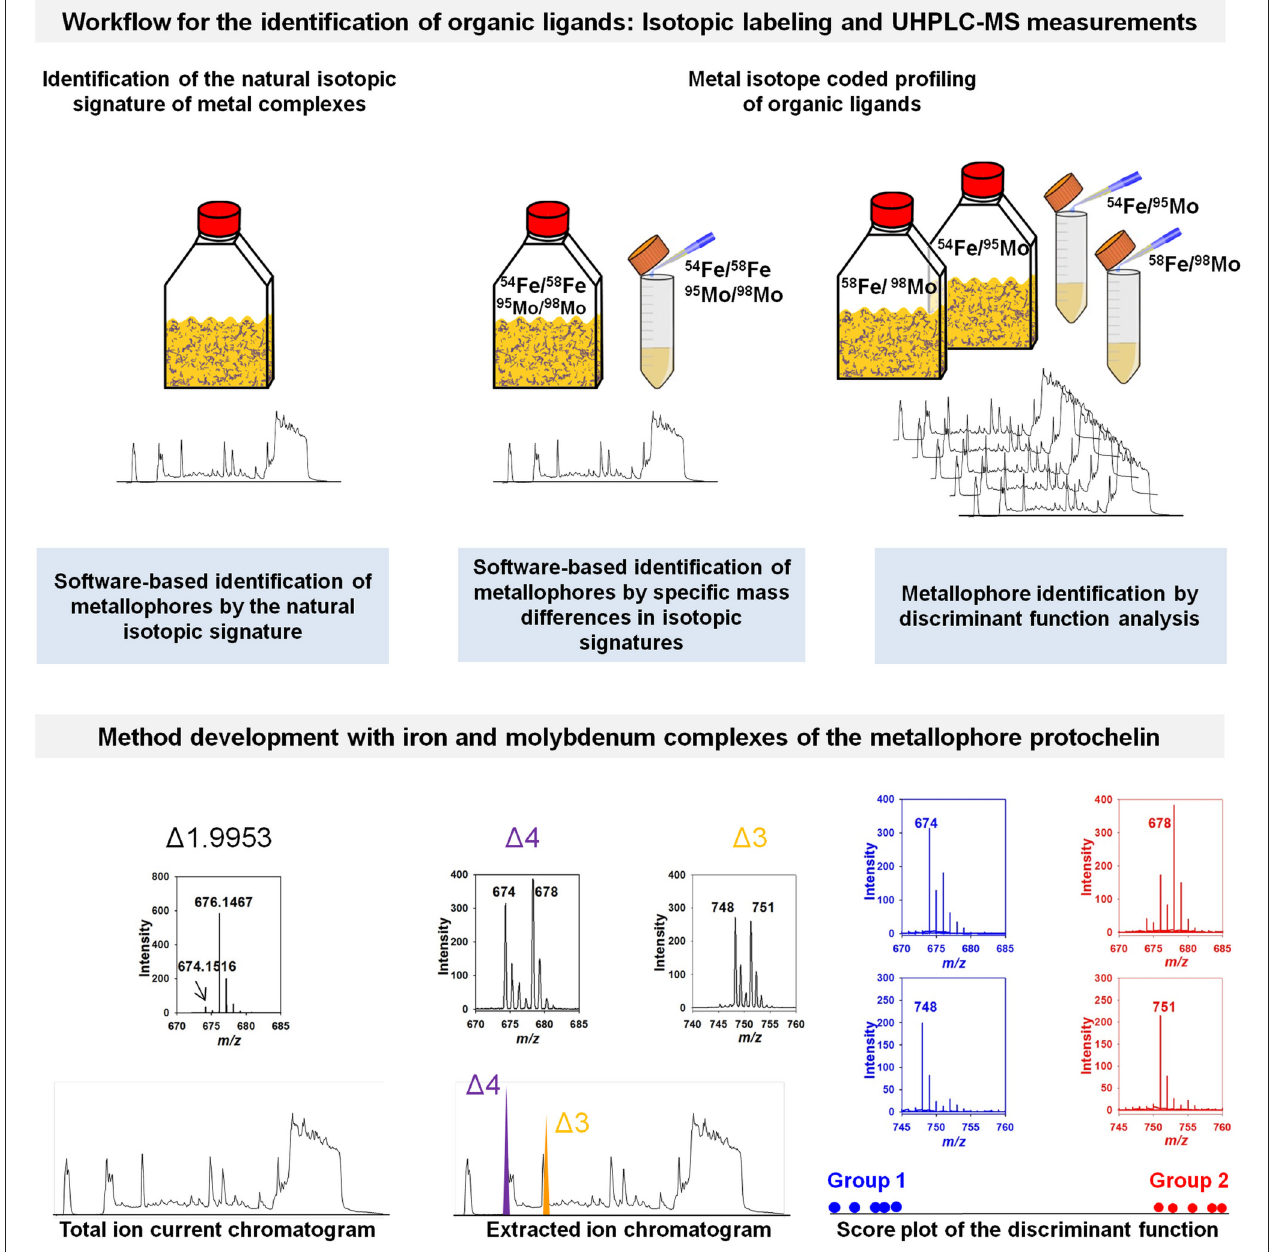
FIGURE 1 | Conceptual workflow for the identification of organic ligands. Three approaches are shown using the isotopic signature of metal complexes for the identification of organic ligands and metallophores (exemplarily demonstrated for the metallophore protochelin). Using high resolution mass spectrometry allows one to identify the natural iron isotopic pattern. Unique isotopic signatures of potential candidates in mass spectra can be identified upon labeling potential chelators with isotopically pure pairs of, for example, 54 Fe and 58 Fe or 95 Mo and 98 Mo in natural samples or extracts with an improved signal-to-noise ratio (Deicke et al., 2014). The inserts show mass spectra (of the respective treatments above) recorded in negative ion mode either by Q-Exactive Orbitrap (Thermo Scientific, Germany) or by Q-ToF (Waters, UK) mass spectrometers coupled to an ultra-performance liquid chromatography (UHPLC). Most importantly, the chelating properties of potential chelators must be preserved during the whole analytical process (Deicke et al., 2013). Data processing can be achieved by identification of specific mass differences in the isotopic signatures or discriminant function analysis as outlined by Deicke et al. (2014). Plots are reproduced from Deicke et al. (2014) with permission from the Royal Society of